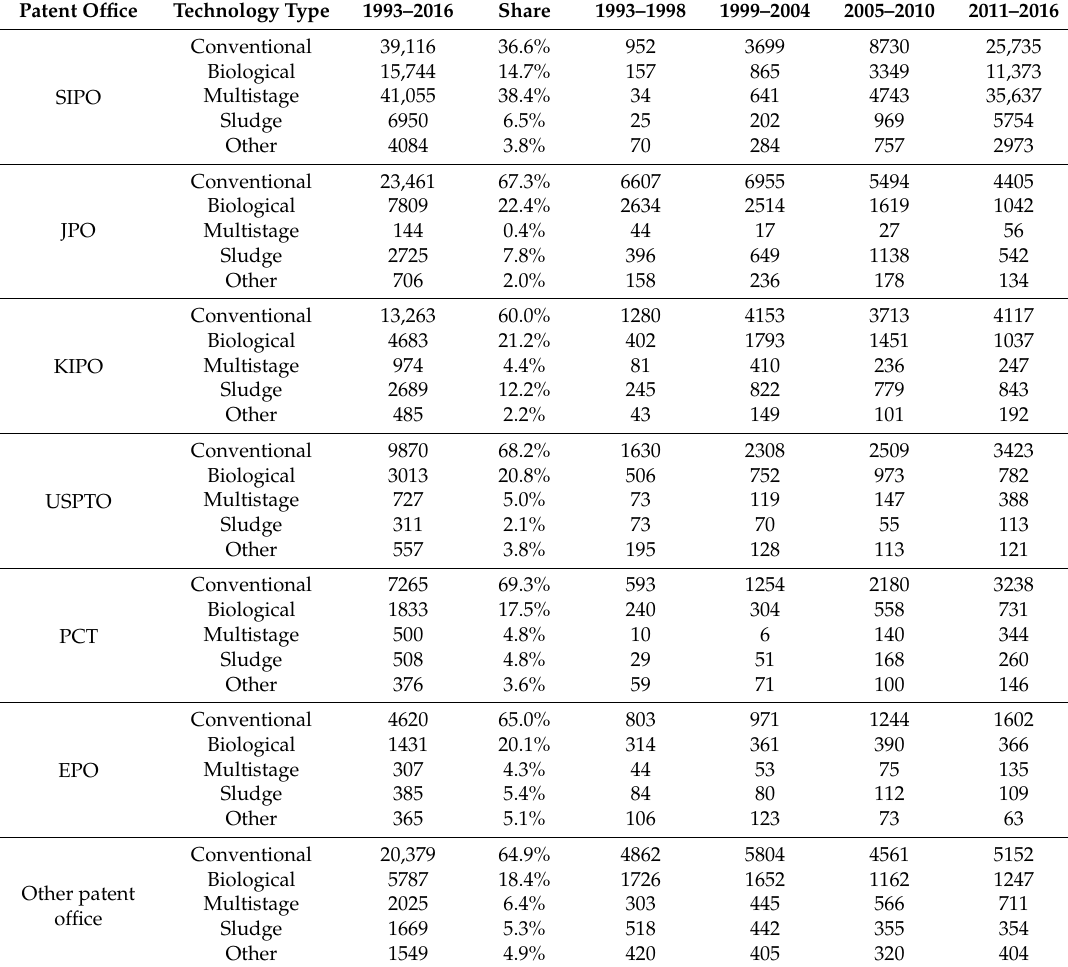
Table 2. Data description of the water treatment technology patents granted (number of